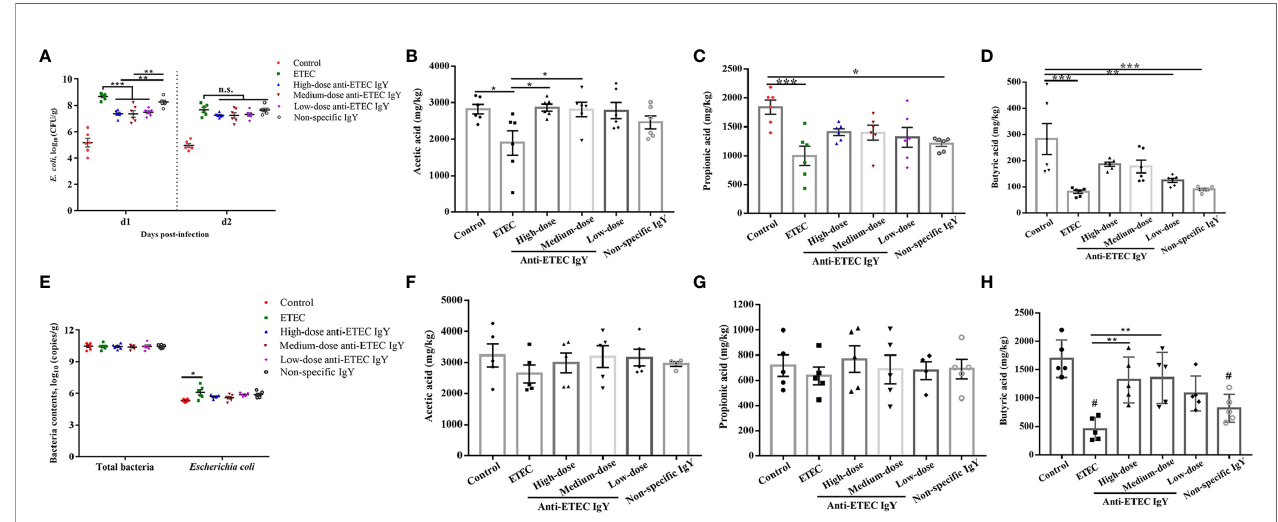
FIGURE 5 | Effects of IgY on bacterial load and microbial metabolites in feces and cecal digesta of ETEC-infected mice. (A) E. coli number in feces of mice on different days post-infection. Mice in ETEC group were challenged with ETEC and treated with PBS. Mice in IgY groups were pre-treated with high-, medium- or low- doses anti-ETEC IgY or non-speci fi c IgY and then challenged with ETEC, n=6 (B – D) Short chain fatty acid (acetic acid, propionic acid, and butyric acid) concentration in feces of mice, n=6. (E) Total bacteria and E. coli content in cecal digesta of mice at day 4 post-infection, n=6. (F – H) Short chain fatty acids (acetic acid, propionic acid and butyric acid) concentrations in cecal digesta of mice, n=5. Values are expressed as least squares mean ± SEM, * P < 0.05, ** P < 0.01, *** P < 0.001. ns, not signi fi cant. # P <0.05 compared to control group.